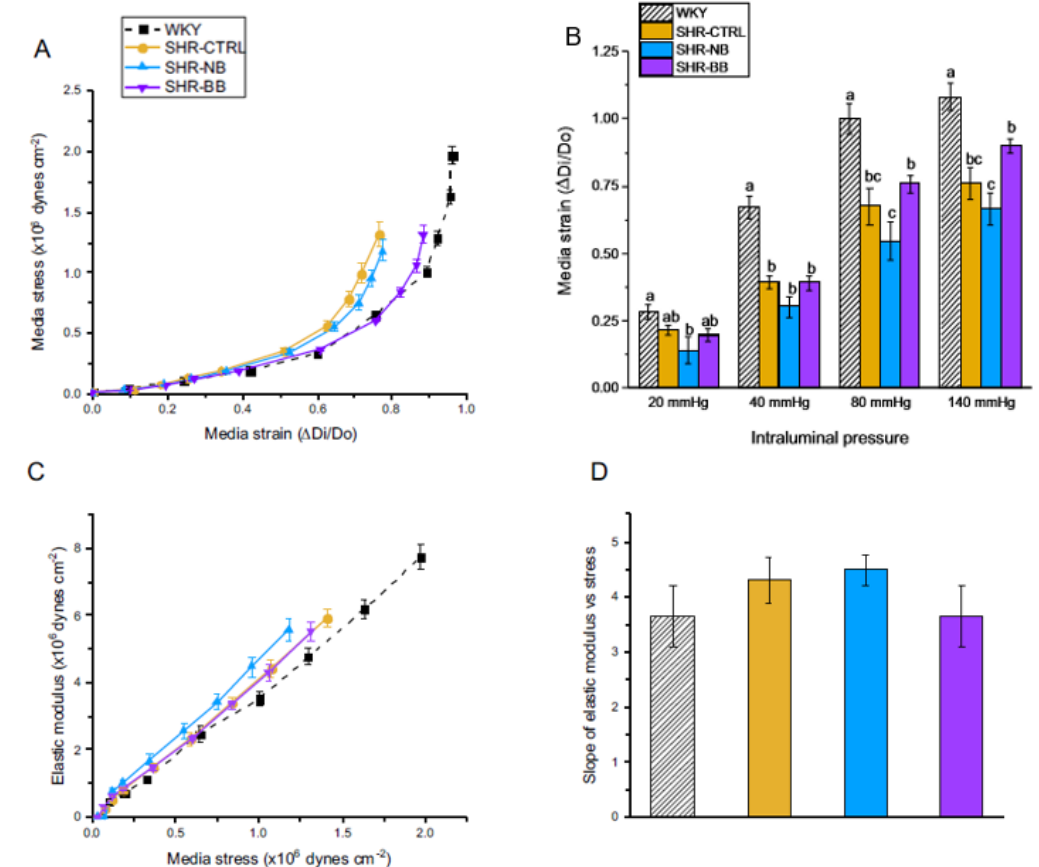
Figure 3. Phase 1: Small-artery vascular compliance. ( A ) Media stress–strain relationship; ( B ) Media strain at intraluminal pressures of 20, 40, 80, and 140 mmHg; ( C ) Elastic modulus vs. media stress; ( D ) Slope of elastic modulus vs. media stress. Vascular compliance measurements of mesenteric resistance arteries were calculated from data obtained at 3, 10, 20, 30, 40, 60, 80, 100, 120, and 140 mmHg on the pressure myograph. Data are expressed as mean ± SEM ( n = 7–10 / group). Di ff erent letters represent significant di ff erences ( p < 0.05) within a given intraluminal pressure in ( B ). An absence of letters indicates no statistical di ff erences in ( D ). Abbreviations: BB, black bean diet; BW, body weight; CTRL, bean-free control diet; NB, navy bean diet; SHR, spontaneously hypertensive rat; WKY, Wistar Kyoto.